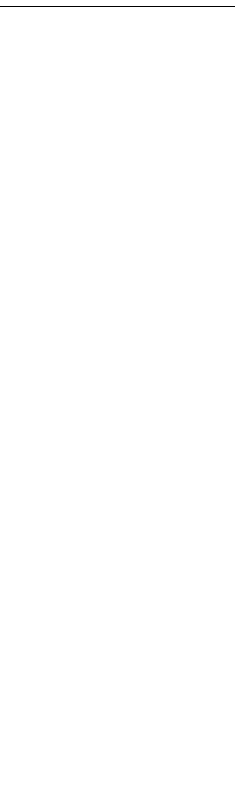
Harskamp R et al . BJGP Open 2018; DOI: